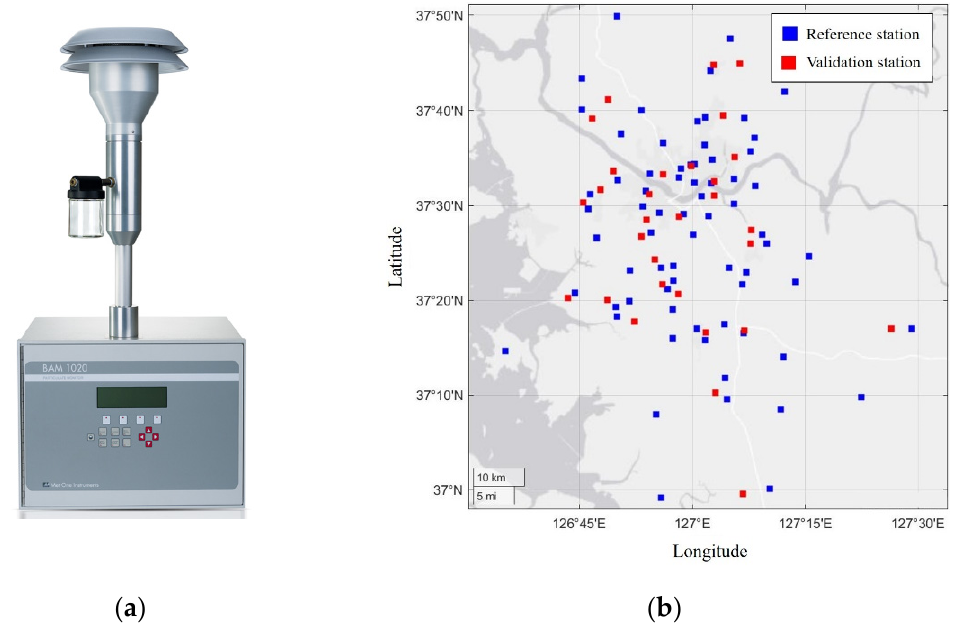
Figure 1. Sensor and station networks for PM monitoring. ( a ) β -ray absorption PM sensor (BAM 1020 Continuous Beta-attenuation Particulate Monitor), ( b ) locations of PM monitoring stations used in experiments.